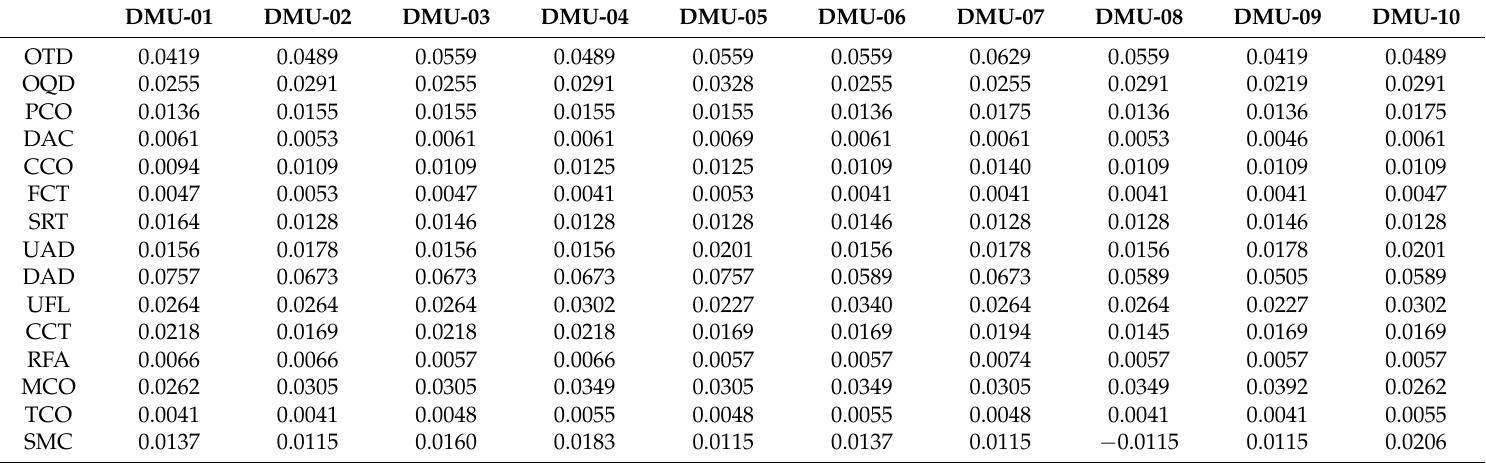
Table 7. Normalized Weight